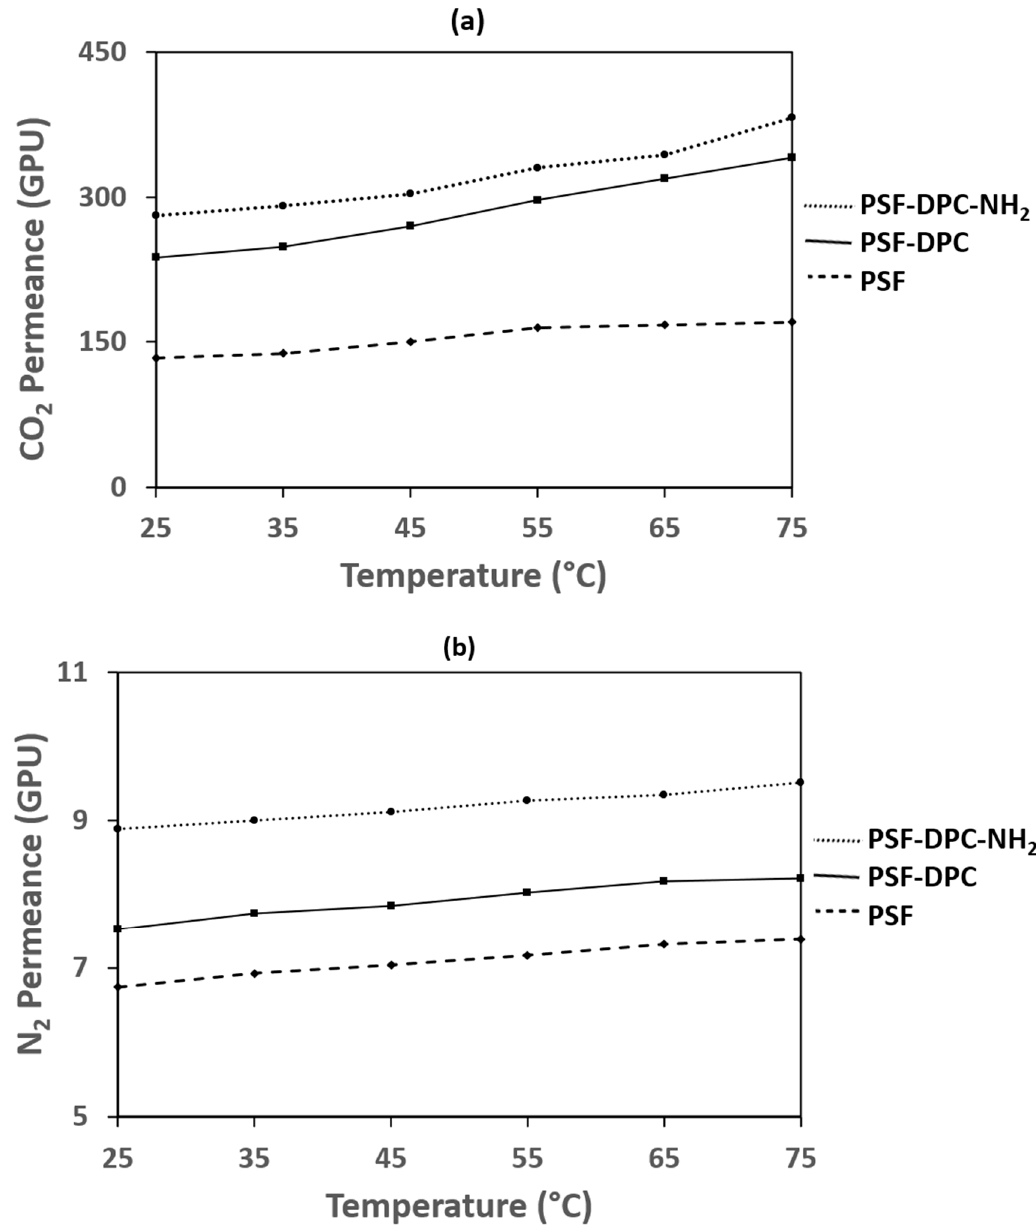
Figure 9. Effect of temperature on the optimum membranes’ ( a ) CO 2 permeance and ( b ) N 2 permeance.